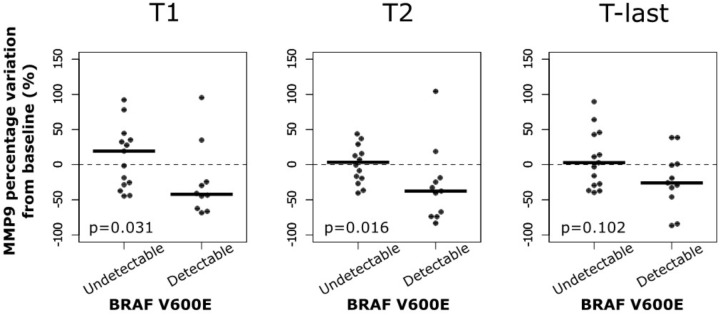
MMP-9 reduction in patients with BRAFV600E mutation at different time. Percentage variation of MMP-9 from baseline to first (T1) and second (T2) clinical examination after treatment initiation and to last follow-up (T-last) according to circulating BRAFV600E mutation.